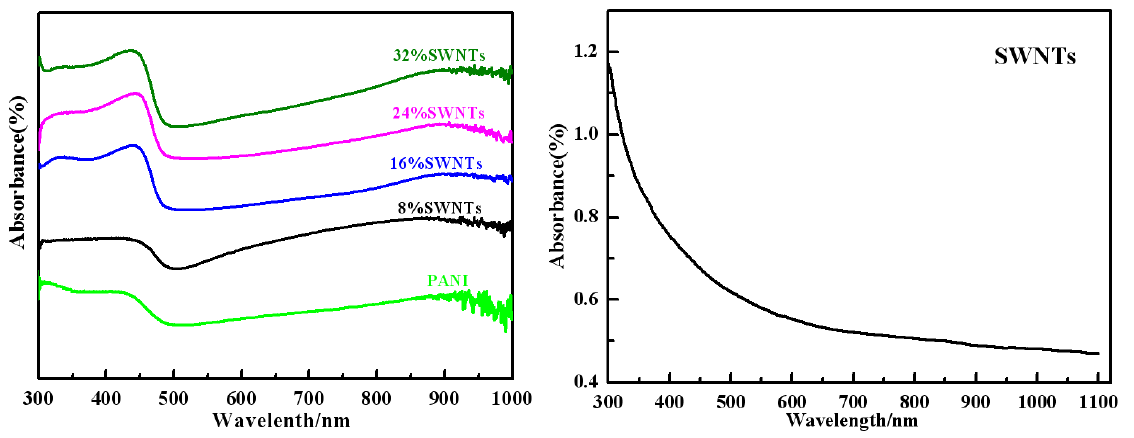
Figure 2. Ultraviolet-visible (UV-Vis) spectra of PANI, SWNTs and PANI/SWNTs composites with content of SWNTs varying from 8 wt% to 32